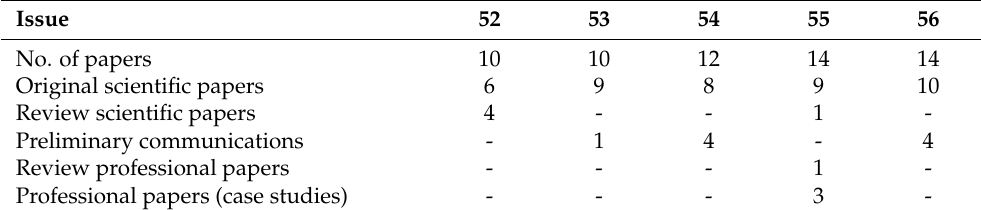
Table 1. Number and categories of papers in five issues published during 2021. There were 60 papers organized into five categories, where 56 were selected as scientific